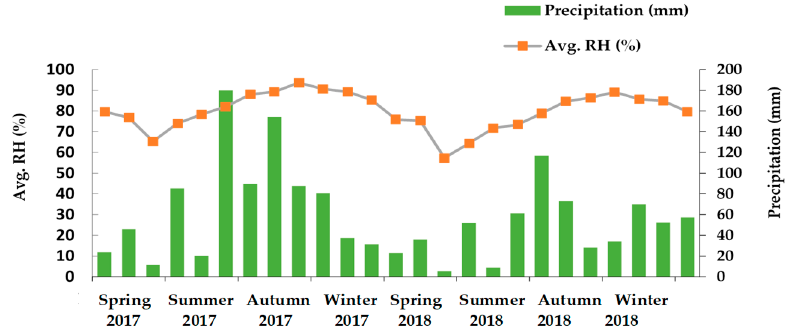
Figure 3. Precipitation and relative humidity during 2-year weathering.